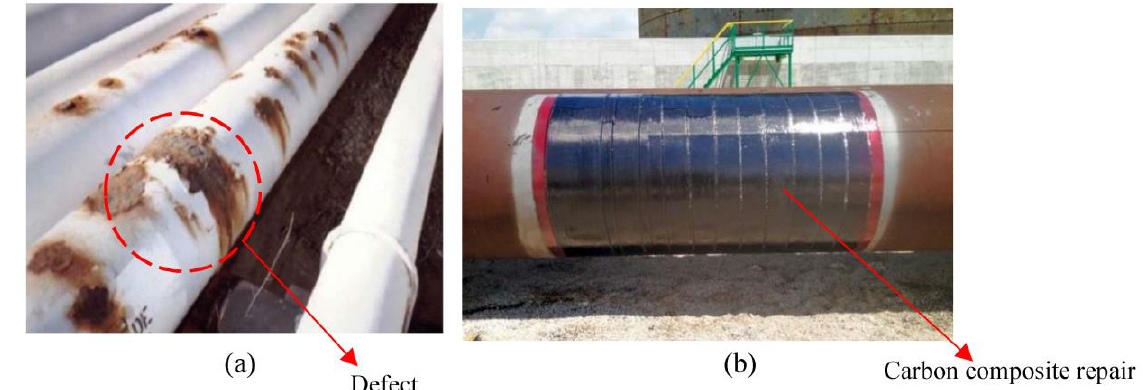
17 of 31 Figure 17. Composite drilling riser for offshore oil drilling: 15 m long, 59 cm inside diameter, 315 bar pressure; manufactured for Norske Conoco A/S and other oil companies (reprinted with permission from Ref. [1]). There are high lengths of oil and gas pipelines in the world, and most of the highest ones are in North American countries. Including these pipelines, it is estimated that 60% of the world’s oil and gas transmission pipelines have been used for more than 40 years and are at risk of defects. External corrosion, internal corrosion, erosion, abrasion, dents and cracks are typical defects that may occur in oil and gas transmission pipelines and potentially lead to disasters and catastrophic incidents. If we do not monitor and repair these pipelines, these defects could make expensive and potentially deadly outcomes to the operators and owners of the pipelines as well as disasters to civilians. Therefore, to prevent further disasters and damages to other intact sections of the pipelines, an urgent repair or replacement of defects at the damaged locations is required, depending on the severity of the defects. Advanced composite wraps have been widely used within oil and gas transmission pipelines over the past two decades for the permanent repair and